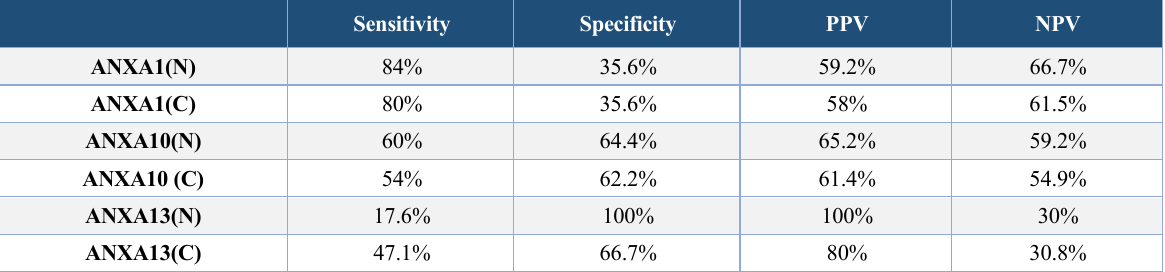
Table 4. Diagnostic test results (sensitivity, specificity, PPV and NPP) of ANXAs to distinguish PDAC from CCA (N, Nuclear & C, Cytoplasmic)